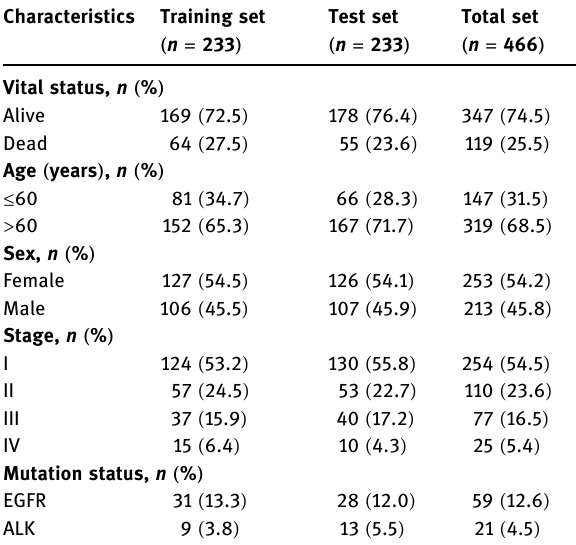
Table 1: Clinical characteristics of LUAD patients Characteristics Training set ( n = 233